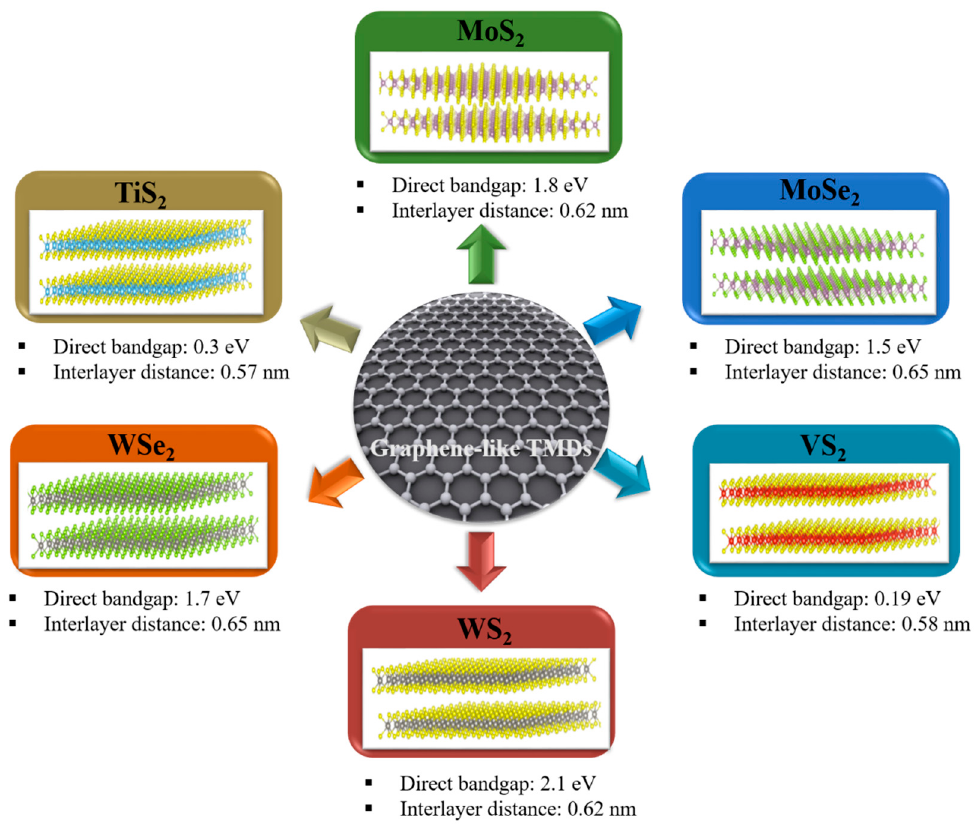
Figure 4. Direct bandgap and interlayer distance of various types of TMD.